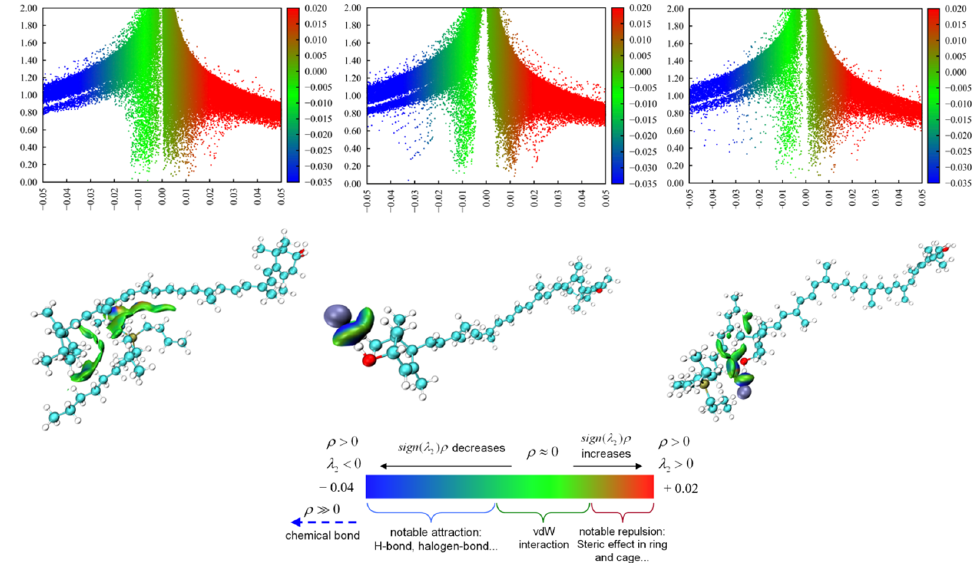
Figure 3. Isosurface diagrams, RDG ( top ) and independent gradient model, IGM ( bottom ) of [P 4448 ] + - lutein ( left ), Cl − 1 –lutein ( middle ), and [P 4448 ]Cl–lutein ( right ) calculated by molecular simulation. The total interaction energy ( E int ) and energy gap ( Δ G ) for the optimized [P 4448 ]Cl– carotenoid structures were calculated with the strength of [P 4448 ]Cl–carotenoid interaction